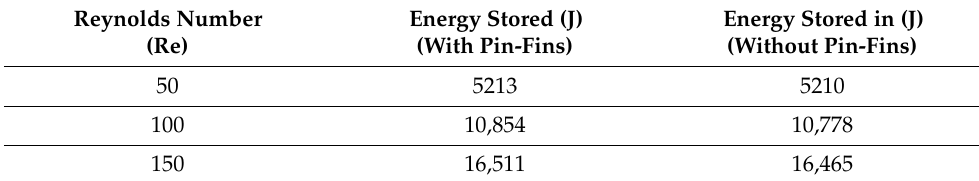
Figure 7. The energy charge P and discharge power Q as a function of Reynolds number and time in the presence of pin-fins ( a ) Re = 50, ( b ) Re = 100, ( c ) Re = 150. Table 3. Total energy stored Q in phase change